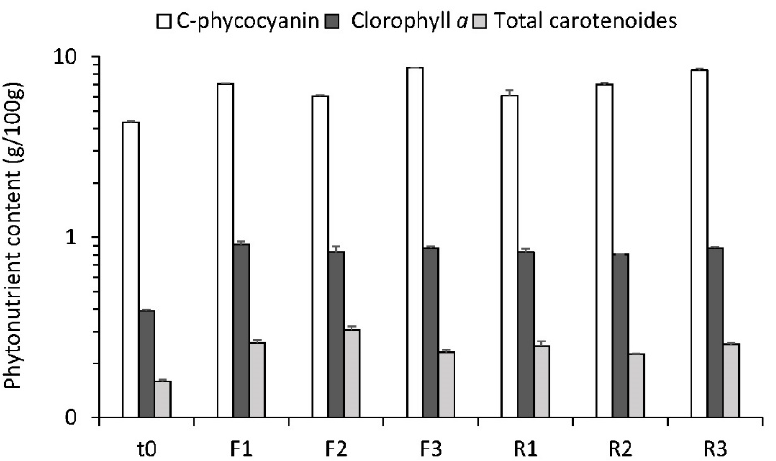
Figure A3. Phytonutrient content (as % of C-phycocyanin, chlorophyll a, and total carotenoids) for samples of A. platensis BEA 1257B biomass collected at the time of inoculation (t0), during the first phase (F phase, 12 Sep. to 11 Oct., samples F1, F2 and F3) and during the second phase of the experiment (R phase, 11 Oct. to 11 Nov., samples R1, R2 and R3) from the 8000 L raceway pond inside greenhouse during the long-term semi-continuous cultivation, individually. Data are presented as the mean of three technical replicates, with error bars representing the corresponding standard deviation ( ± SD). Legend: White graph bars—C-phycocyanin; Black graph bars—Chlorophyll a ; Gray graph bars—Total